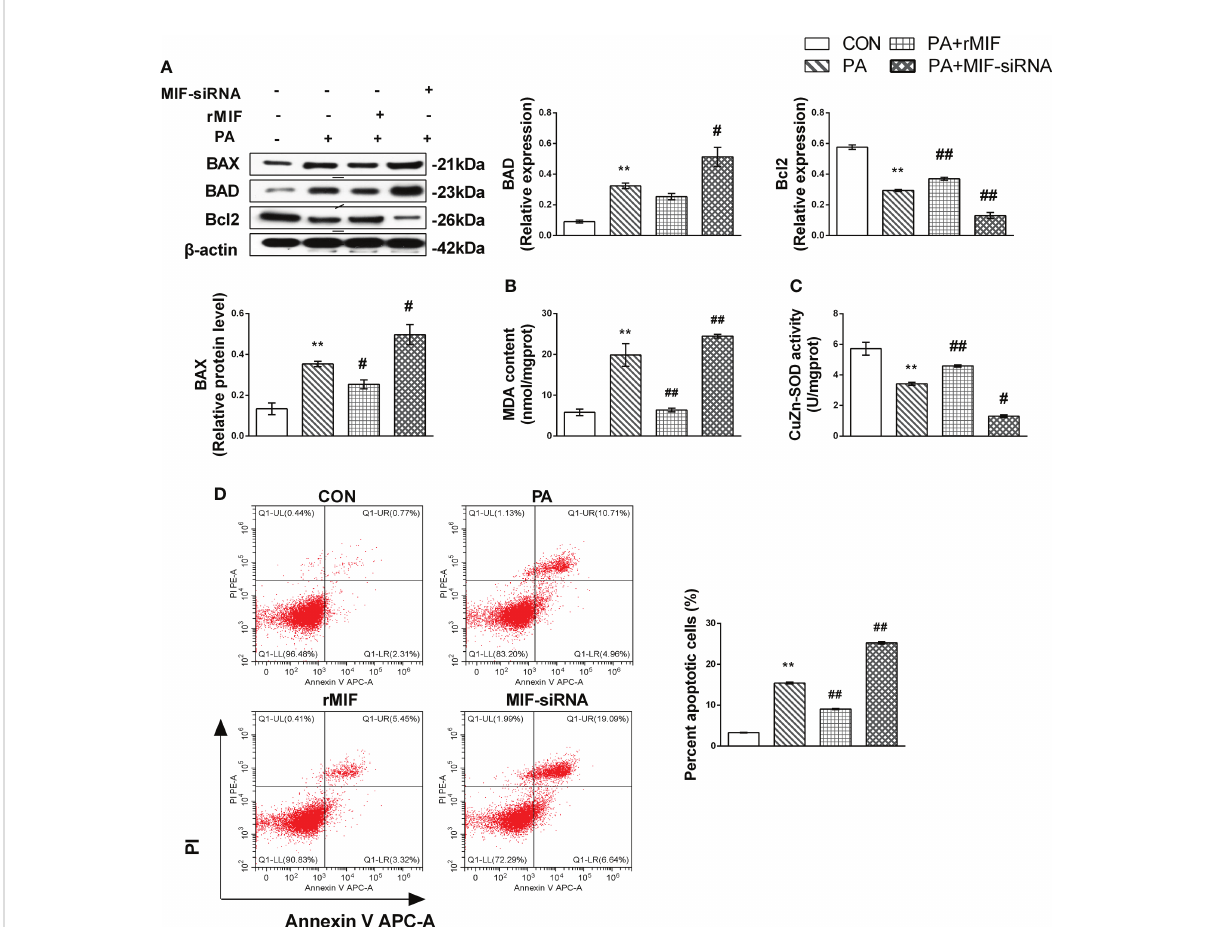
FIGURE 7 MIF regulates JNK-mediated lipotoxicity in PA-treated HepG2 cells. HepG2 cells were cultured with 400 mmol/L PA for 24 h and then added exogenous rMIF 200 ng/ml for 24 h or transfected with MIF siRNA; protein expression levels of BAD, BAX, and Bcl2 (A) were detected by Western blot analysis. CuZn-SOD activity and MDA contents were measured (B, C) . Quanti fi cation of immunoblots is shown in the graphs below the blots. Apoptotic cells were identi fi ed by fl ow cytometry ( n = 3 per each) (D) . ( n = 3 per group) M ± SEM. * P < 0.05 versus Con; ** P < 0.01 versus Con; # P < 0.05 versus PA; ## P < 0.01 versus